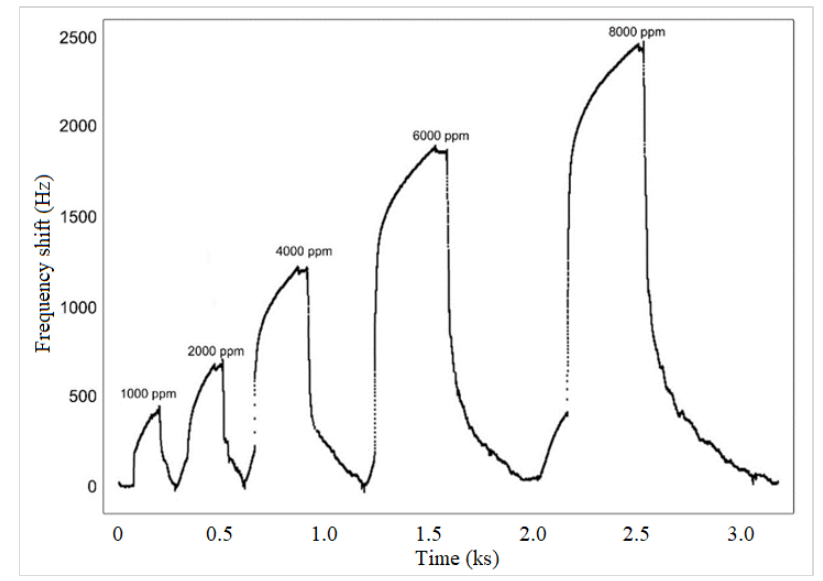
Figure 7. Dynamic response of sensor PMMA QDs to hydrogen for various concentrations.